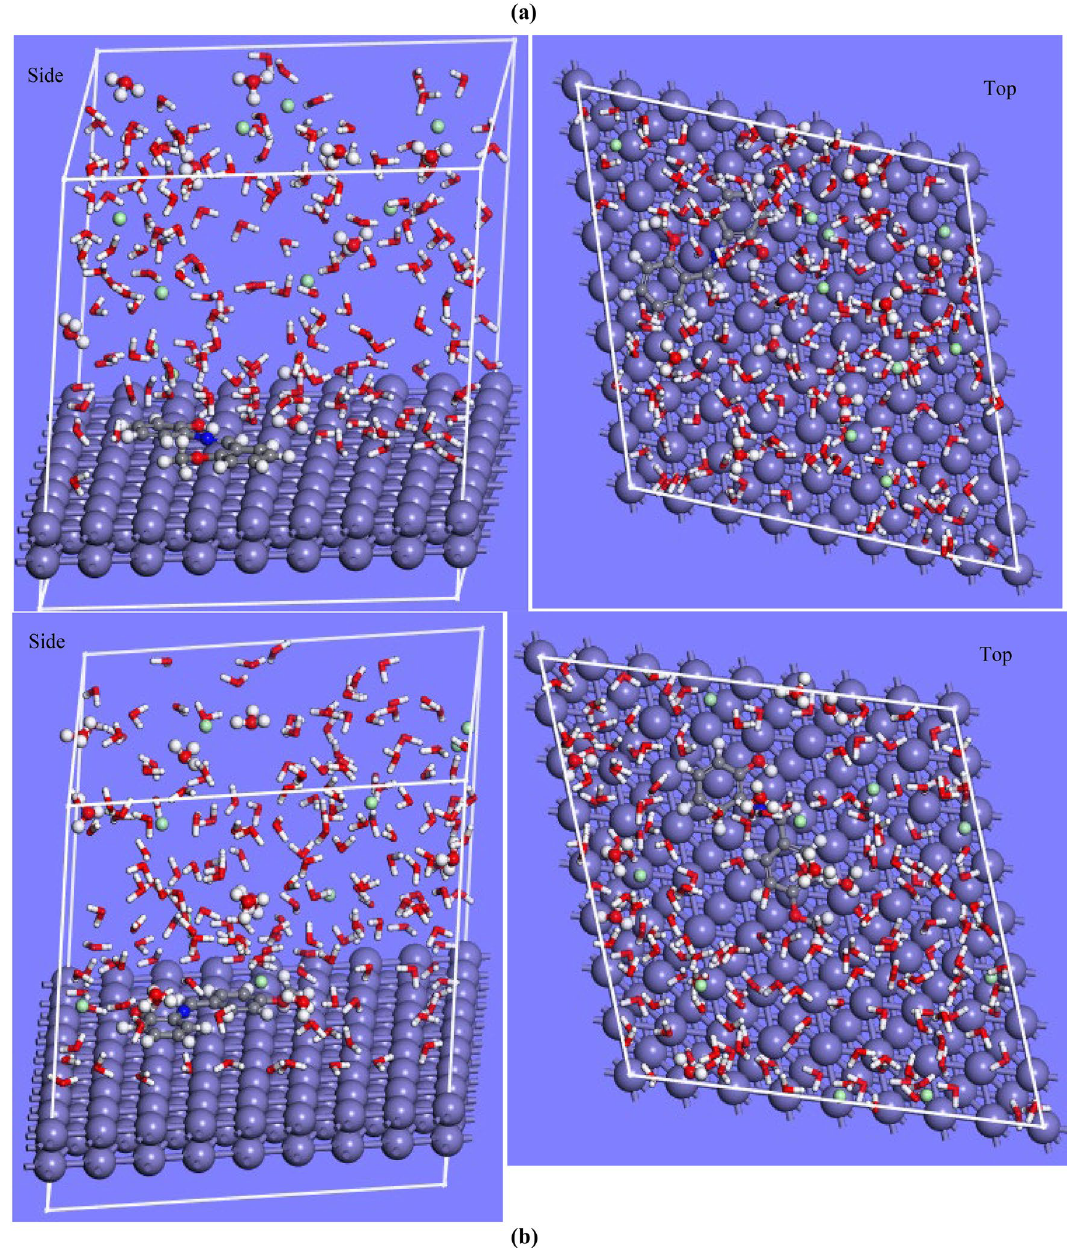
Figure 8. 3D depiction of the Side and top views showing suitable conformation for adsorption of ( a ) L1 and ( b ) L2 on Fe (110) surface in aqueous